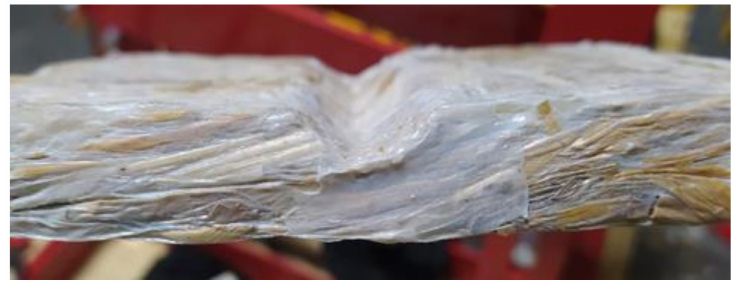
Figure 10. Central groove created to ease the bending process.